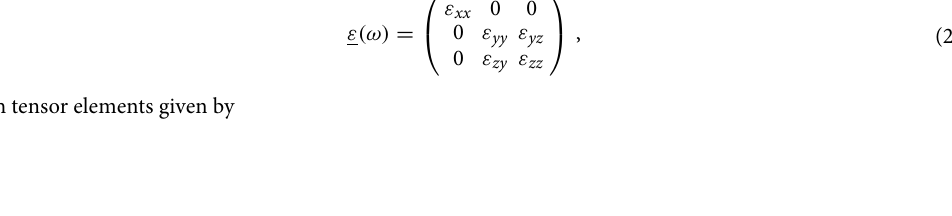
e e e x (red vectors) or − x (blue vectors). Note that x is the + θ ) is − 0 (or 180 ◦ ) and θ 90 ◦ are called the Faraday and Voigt = = e y + 0 =